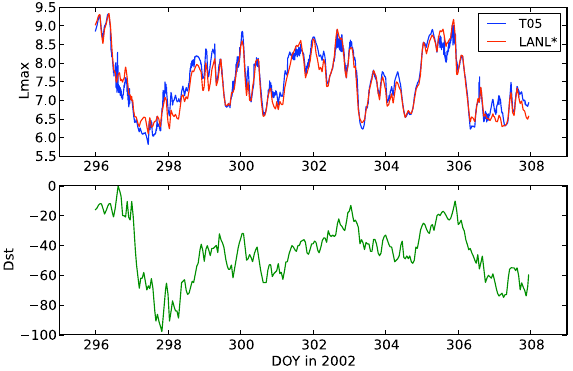
Fig. 7. Time series plot of the last closed drift shell L max as it was calculated for solar wind conditions from 23 October 2002 to 4 November 2002 using TS05 (blue) and the LANL* neural net- work (red) for pitch angle α loc =90 ◦ . Even for a moderate storm, the last closed drift shell can vary between L ∗ =6 − 9 .